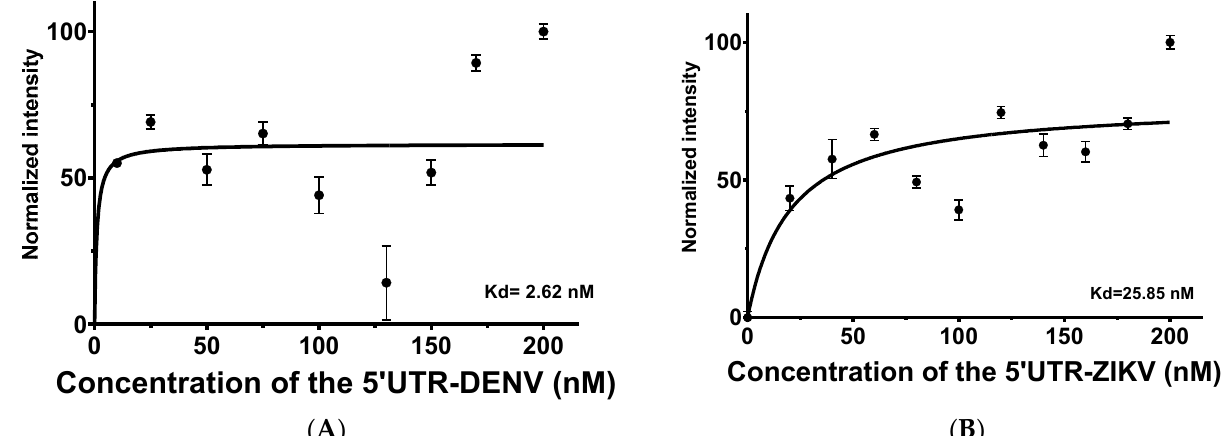
Figure 4. Aptamer-target titration in the presence of 50 nM of the APTAZC10-MB by FRET evaluations. ( A ) Dissociation constant of the APTZAC10-MB and 5’UTR of DENV2 interaction; ( B ) Dissociation constant of the APTZAC10-MB and 5’UTR-ZIKV interaction.